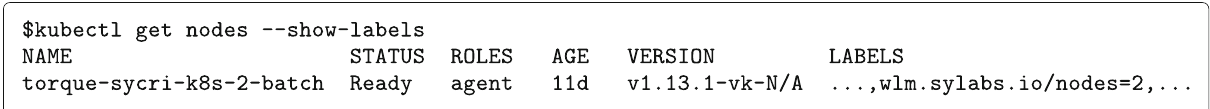
Fig. 6 The virtual node generated by Torque-Operator. Only one node label is displayed and the rest is omitted in the figure for simplicity